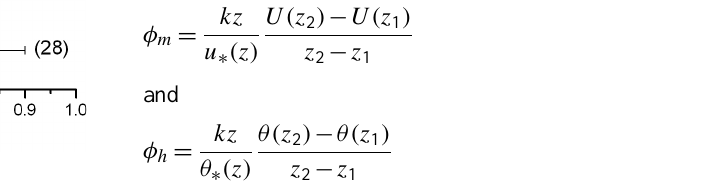
Fig. 1. Vertical profile of leaf area index (LAI) density and its stan- dard error of mean with sample number in parentheses, measured in June 2003 when the forest height ( h) was 13.1m. The total LAI was 2 . 85 ± 0 .